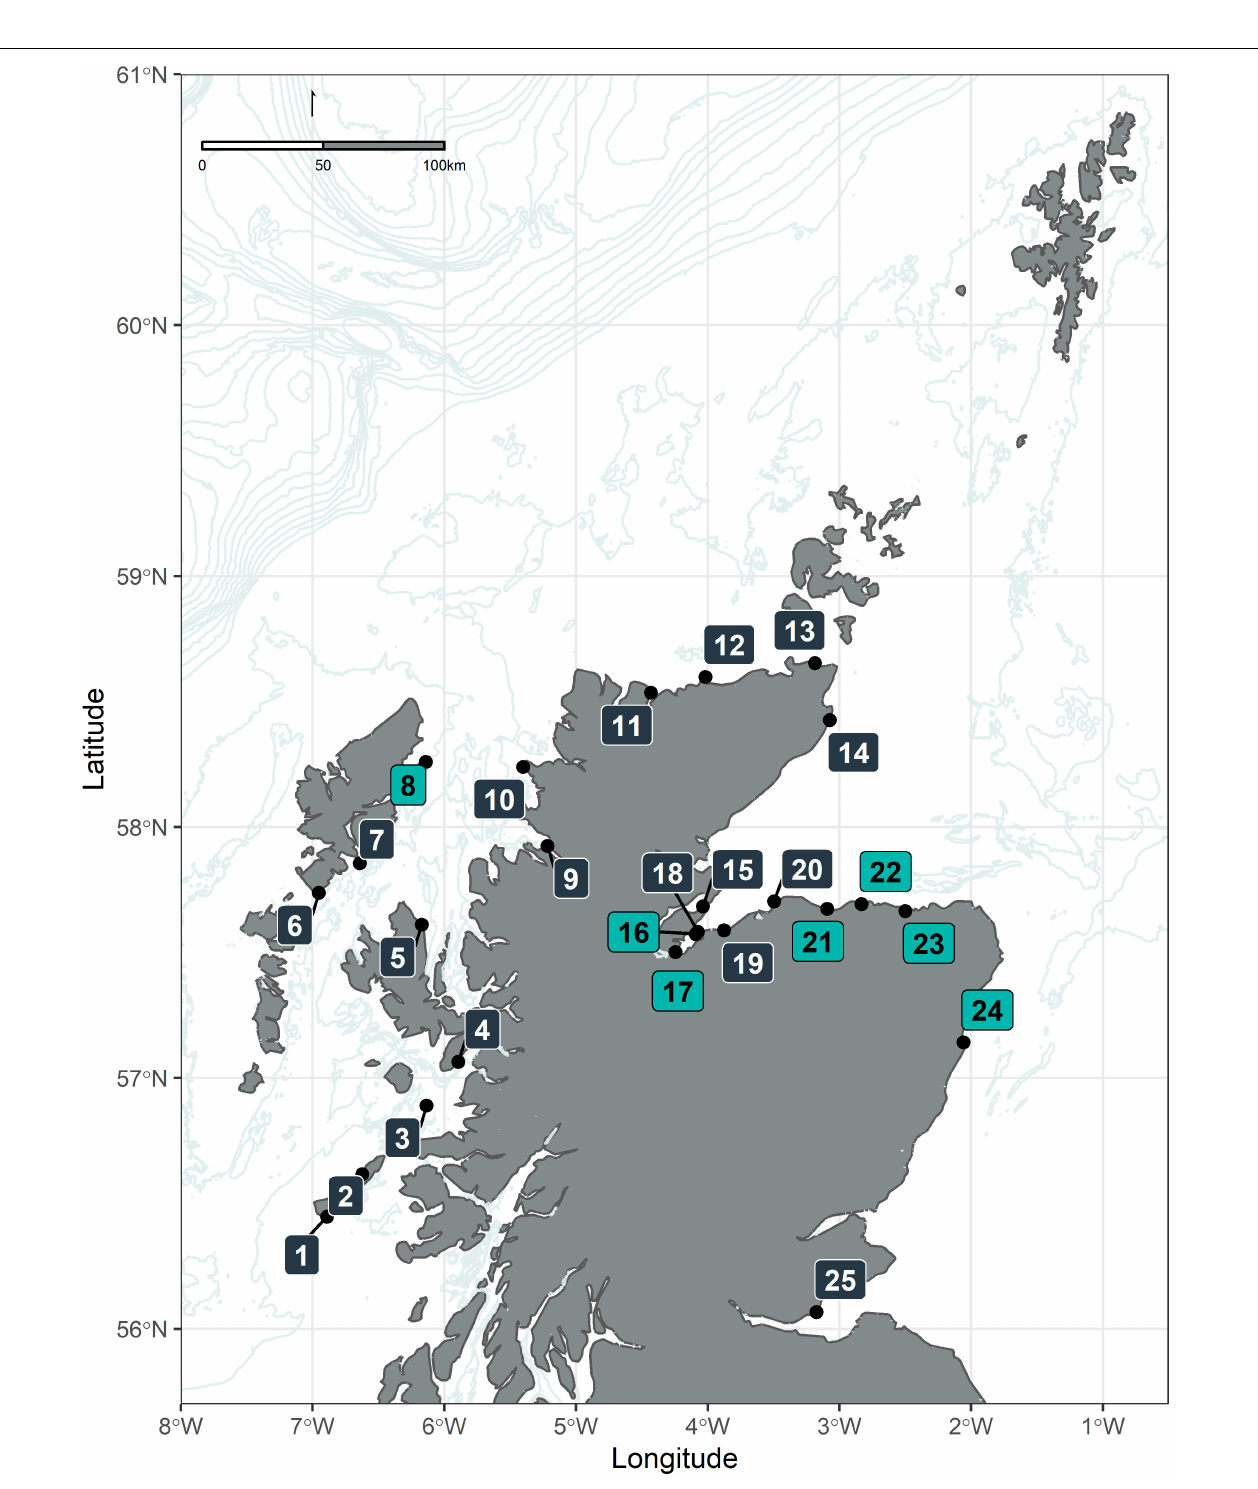
FIGURE 1 | Map of the study area. The map describes the position of the observation sites of the Whale and Dolphin Conservation Shorewatch program: (1) Hynish Watch Tower (Tiree); (2) Hough Bay (Coll); (3) Eigg Pier (Eigg); (4) Armadale Pier (Skye); (5) Kilt Rock (Skye); (6) Rodel (Harris); (7) Scalpay Lighthouse (Harris); (8) Tiumpan Head (Lewis); (9) Rhue Lighthouse (Ullapool); (10) Stoer Head Lighthouse; (11) Melness Church (Talmine); (12) Strathy Point; (13) St John’s Point (Caithness); (14) Castle of Old Wick; (15) Cromarty; (16) Chanonry Point; (17) North Kessock; (18) Fort George; (19) Nairn viewpoint; (20) Burghead; (21) Spey Bay (Scottish Dolphin Centre); (22) Cullen; (23) Macduff; (24) Torry Battery (Aberdeen); (25) Kinghorn (Fife). Observation sites colored in light blue indicate those locations used for further analysis in this study.